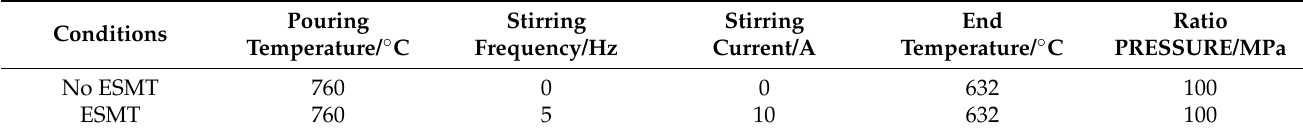
Table 2. Melt treatment parameters under different conditions.